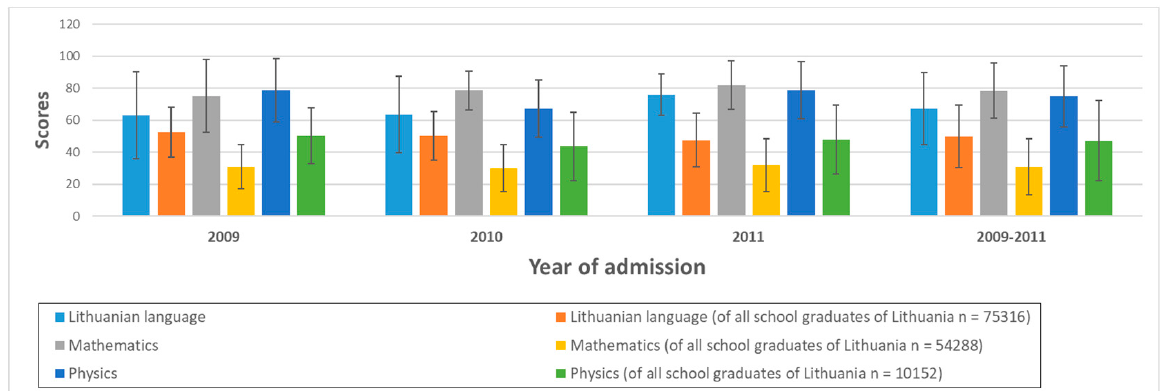
Figure 1. Correlation of the maturity examination assessment scores with the year of admission (source: created by the authors).